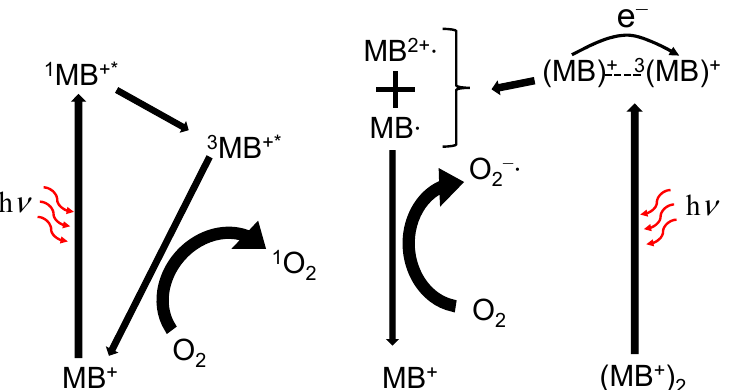
Figure 9. Methylene blue photochemical reaction routes where MB + , 1 MB +* , 3 MB +* are methylene blue ground state, singlet and triplet excited states, respectively; MB · and MB 2+ · are methylene blue semi-reduced and semi-oxidized radicals, respectively.